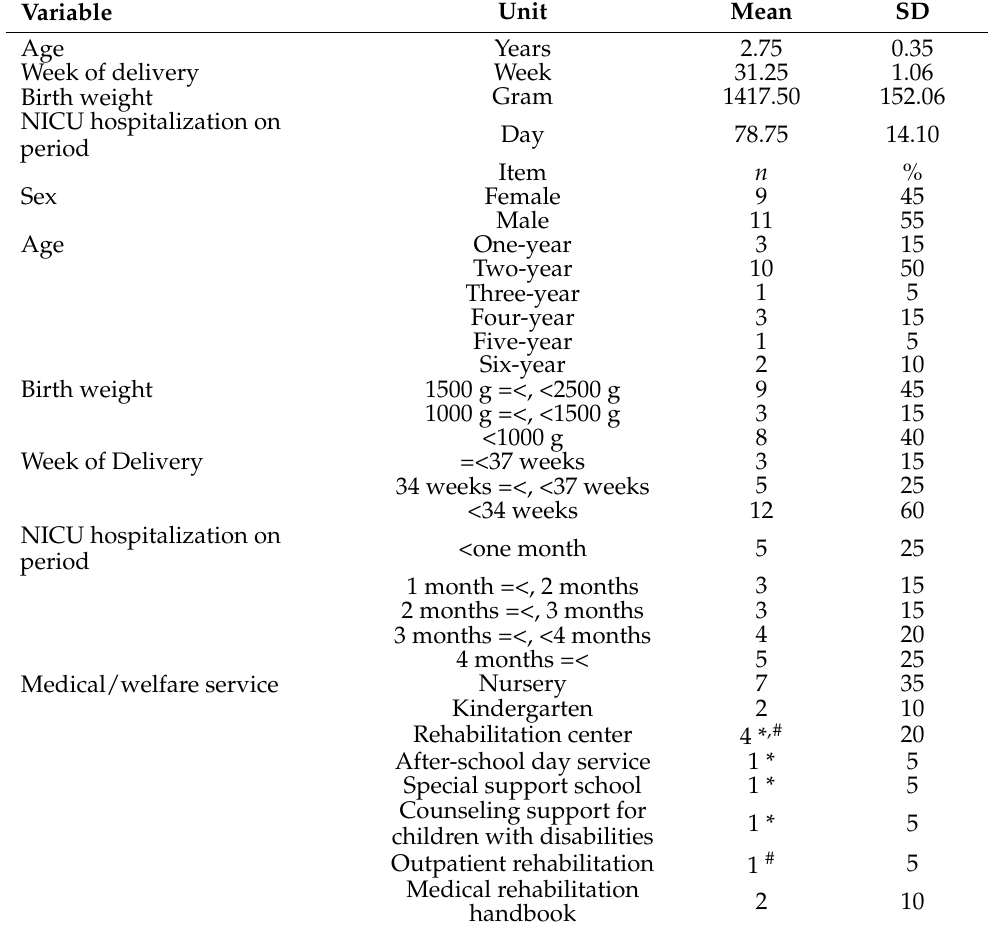
Table 2. Demographic of low birth weight infant ( n =